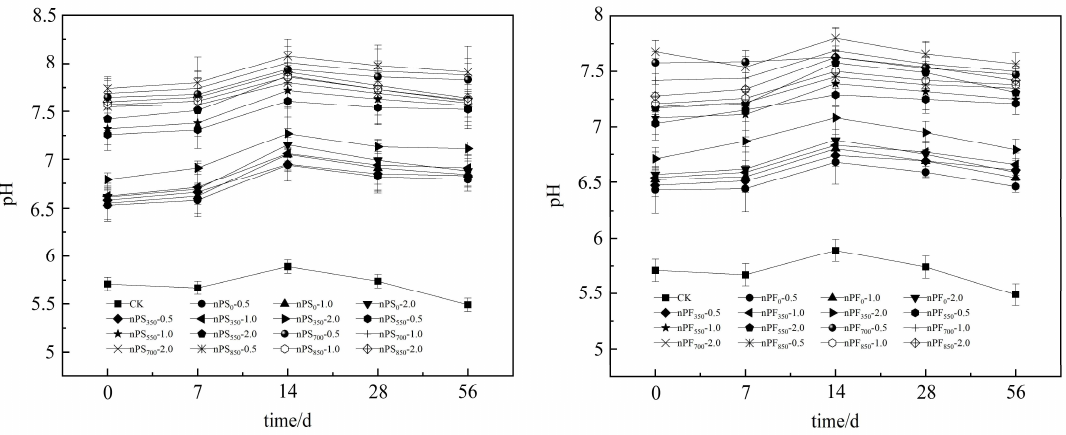
Figure 1. Changes of pH in Cd-contaminated soil with different treatments . Error bars ( n = 3).